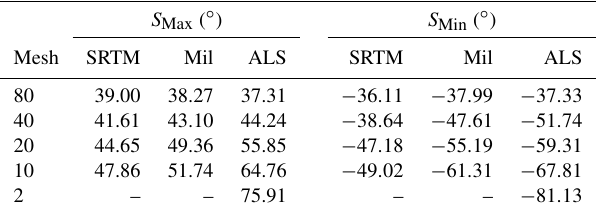
Table 4. Maxima and minima slope in the x (SW–NE, 225 ◦ ) direc- tion, based on SRTM, Mil and ALS terrain